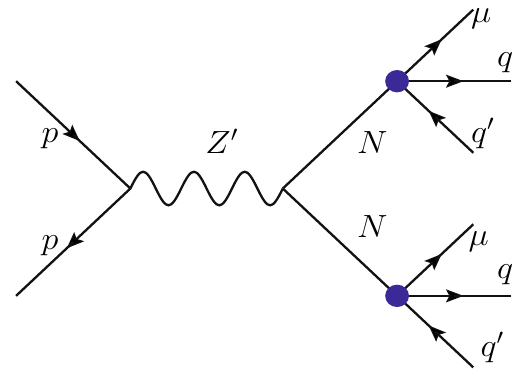
Fig. 2 Feynman diagram representing pair-production of two RHNs via Z (cid:2) mediation and its displaced decays to a lqq (cid:2) final